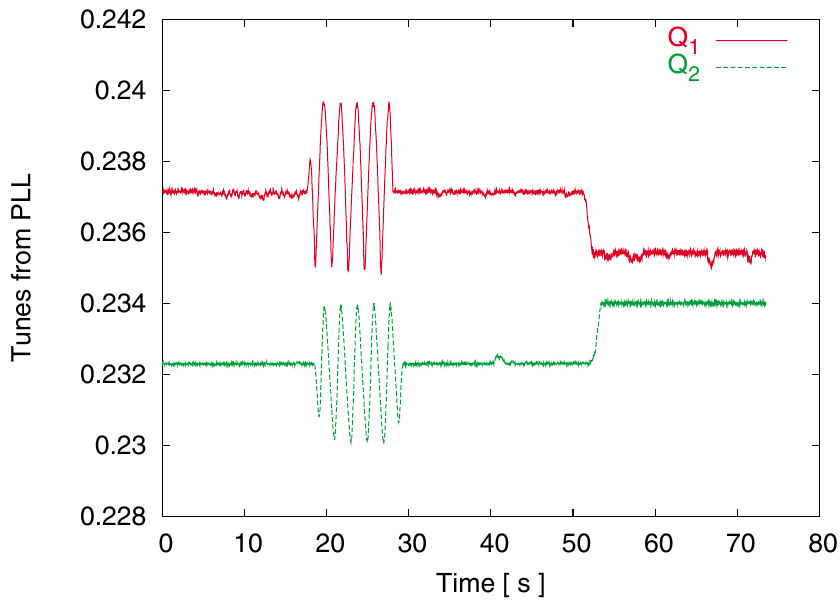
FIG. 2. (Color) The tunes during the coupling angle modulation correction in the RHIC Blue ring